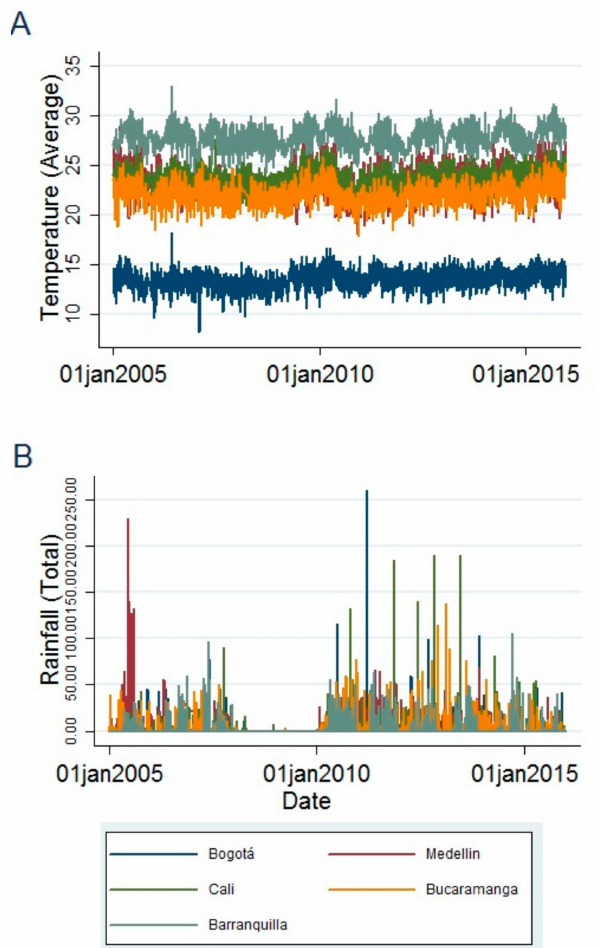
Figure 2. Weather variables of the five main cities of Colombia, 2005–2015. ( A ) Average daily temperature, ( B ) Daily